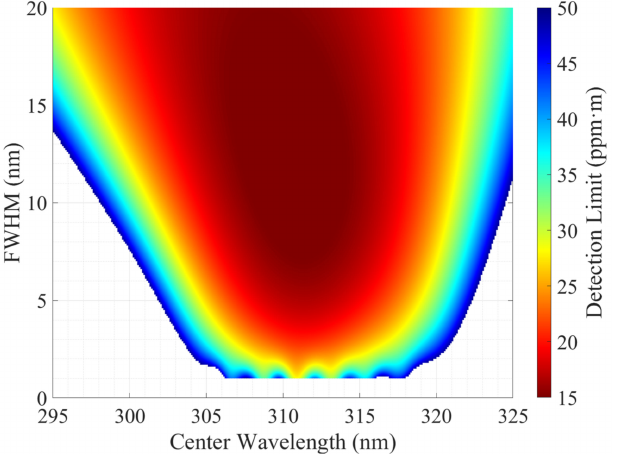
Figure 5. Dependence of the detection limit of the camera system on the filter central wavelength and bandwidth. The improper central wavelength and narrow transmittance window can significantly reduce the detection limit of the camera. By calculation, the optimum detection limit of the camera is obtained when the central wavelength of the signal channel filter (Filter A) is 309 nm with FWHM of 10